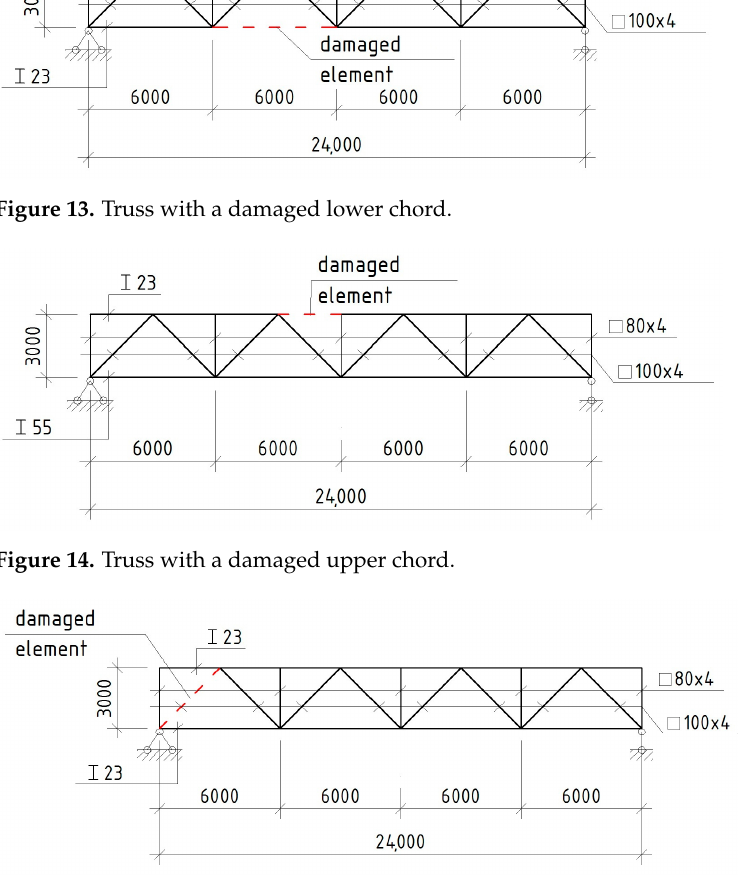
Figure 16. Truss with a damaged middle brace. De fl ections are de fi ned at joint A in the middle of the truss span. The theoretical val- ues of the dynamic coe ffi cient are presented in Table 1.